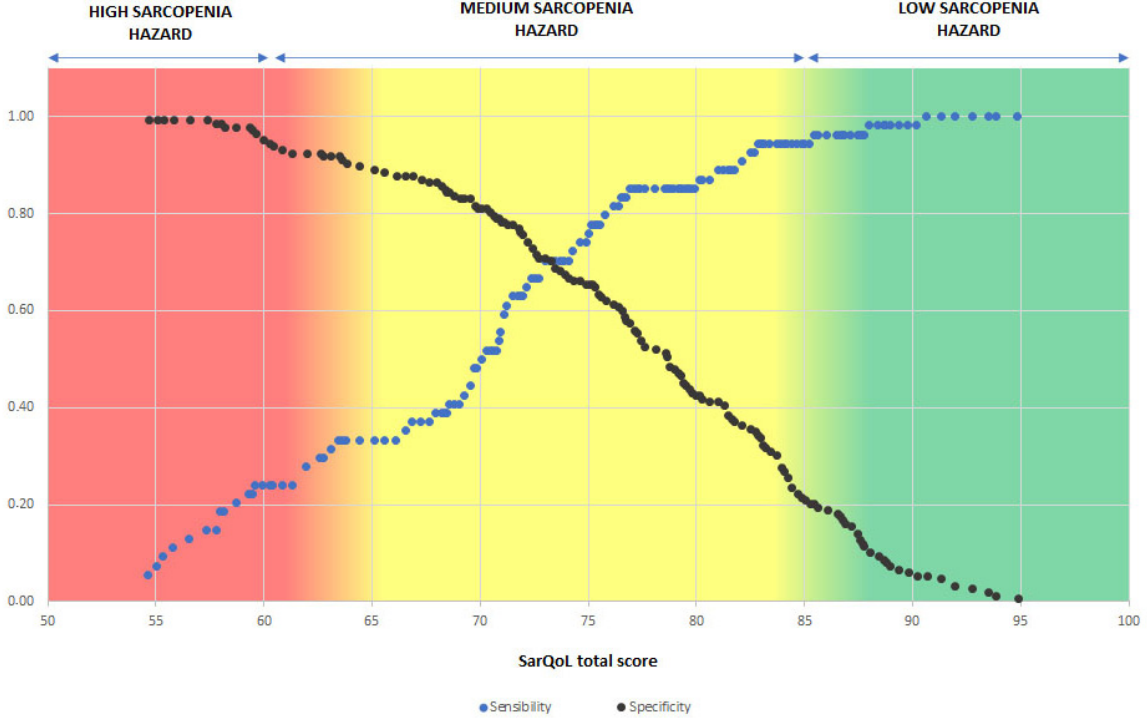
Figure 2. Sarcopenia hazard based on the result obtained in the SarQoL questionnaire, assessing the sensitivity and specificity for the scores obtained.